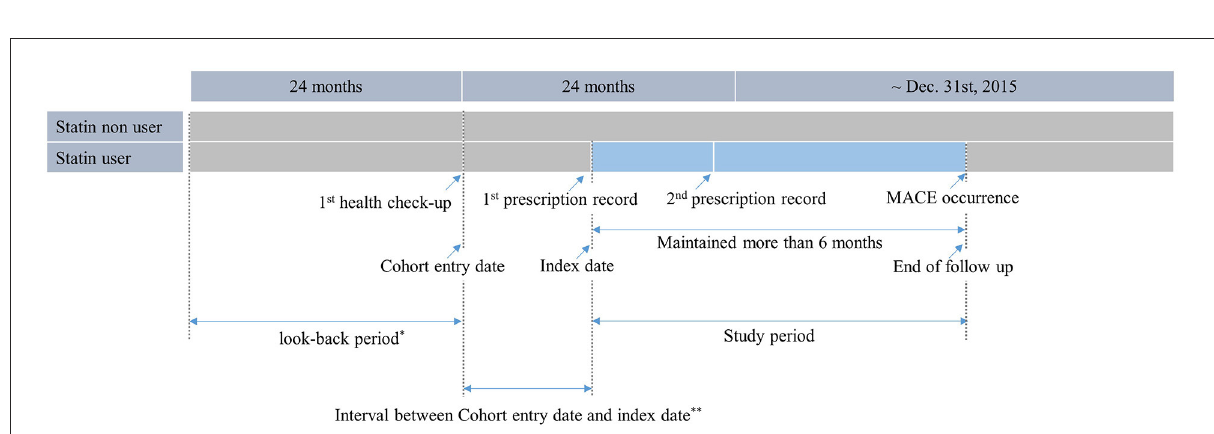
effective in distinguishing cases from non-cases (area